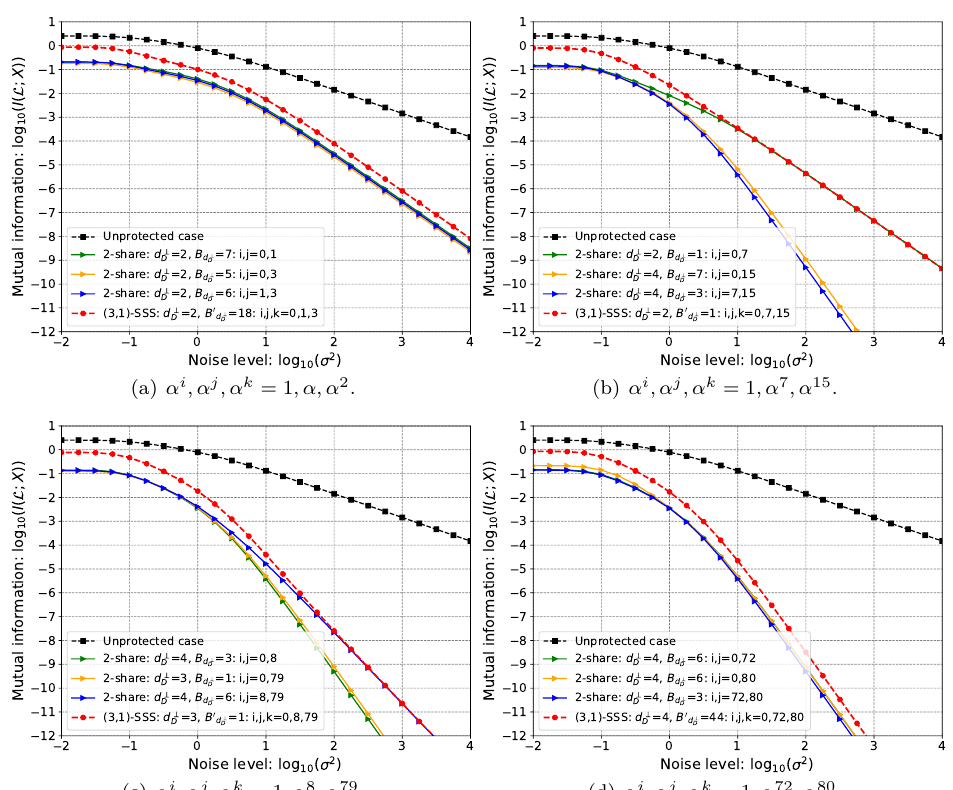
Figure 4: More shares leak more information, two study-cases on (3 , 1)-SSS based masking, where the three public points are: α best candidates for (3 , 1)-SSS based masking. In addition, the generator matrices of all three optimal (nonequivalent) codes are shown in Appendix B.3. It is worth noting that the codes obtained by permuting the order of α only three optimal codes for (3 , 1)-SSS based masking over F